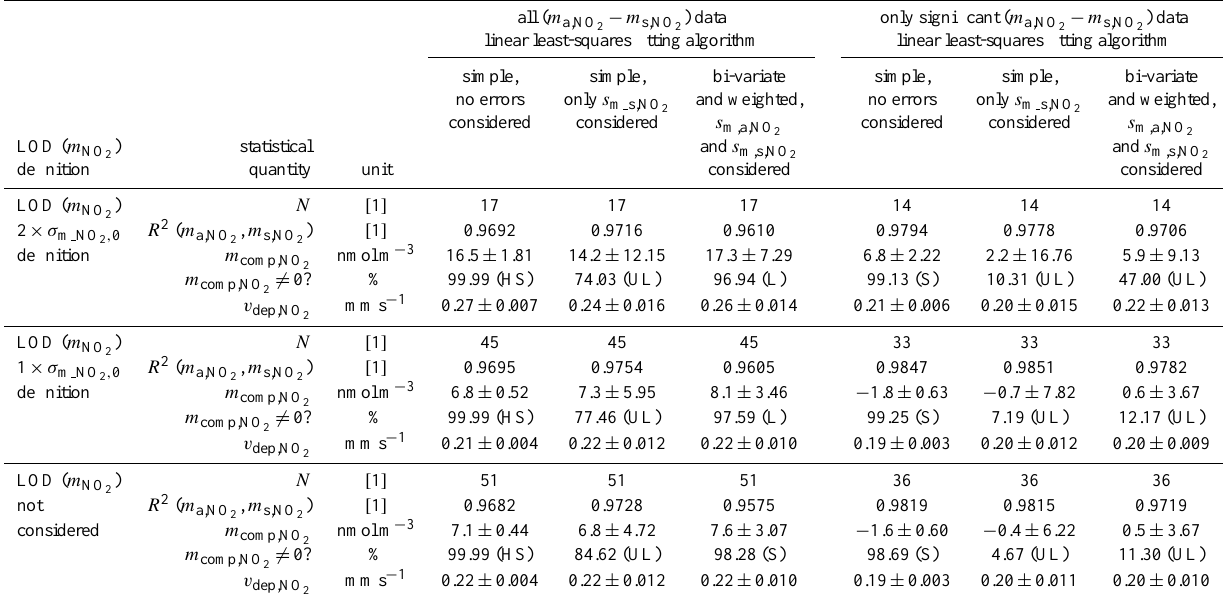
considered) and 2